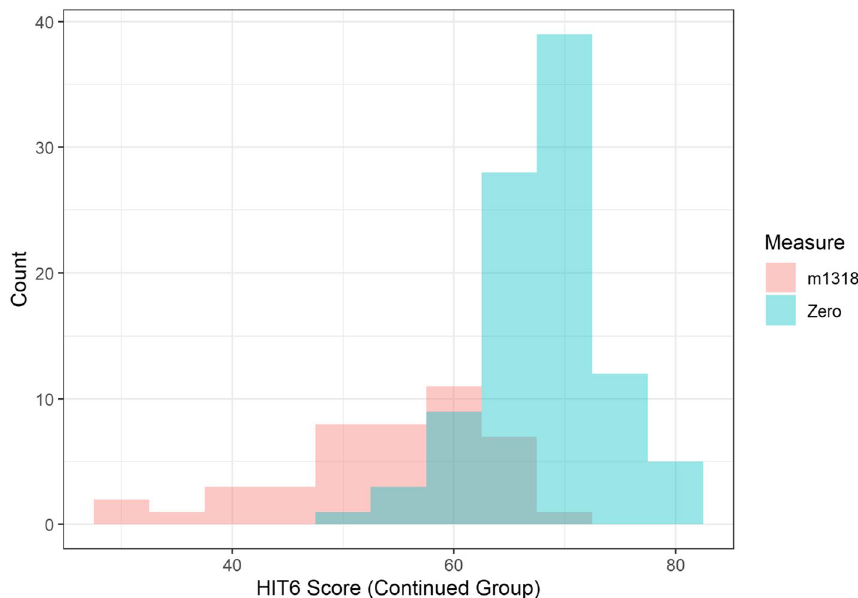
Fig. 4 Histogram comparing times Zero and m1318 distribution of HIT6 scores for patients who remained on treatment beyond June